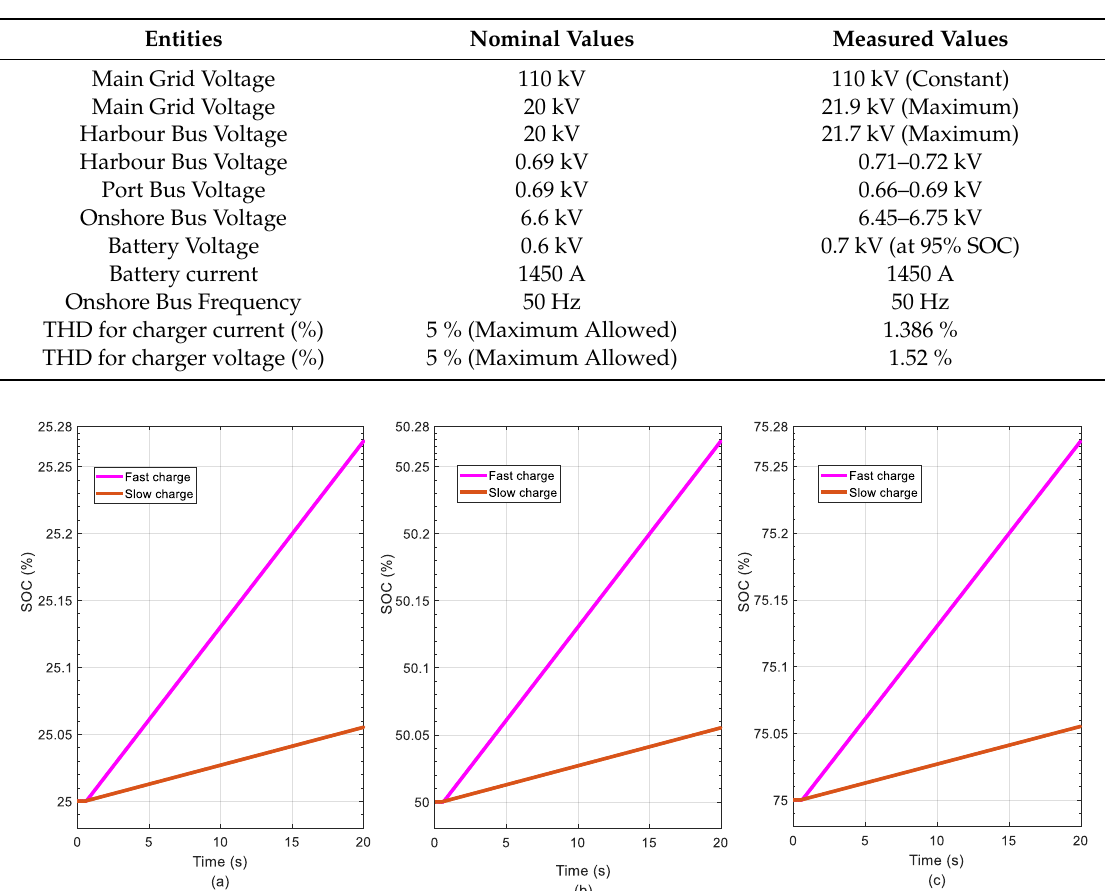
Figure 8. Voltage and power at onboard and charger buses in configuration D. 5. Discussion The findings reveal that BESSs can play a significant role in the onboard and onshore marine sectors as a result of several beneficial features. The application of BESSs onboard a vessel can increase the operational life of diesel generators and reduce their maintenance cost. It can also improve the dynamic response to varying propulsion loads by providing peak load power instantly and store energy during low load power requirements. As a part of a shipboard power system, a BESS can also save fossil fuels and increase energy efficiency in modern hybrid vessels. At the same time, the application of a BESS in a modern HASG can enable the use of renewable energy sources at shoreside in harbour areas and support a weak grid in the case of power unbalance, stability and reliability issues. A BESS in harbour areas can also be used as an energy management system to optimally and efficiently control energy flows between the BESS and the main grid for the purpose of energy arbitrage and peak shaving. Moreover, in the islanded mode of operation of an HASG, load shedding may not be a viable option because of the importance of keeping to the schedule of a vessel’s